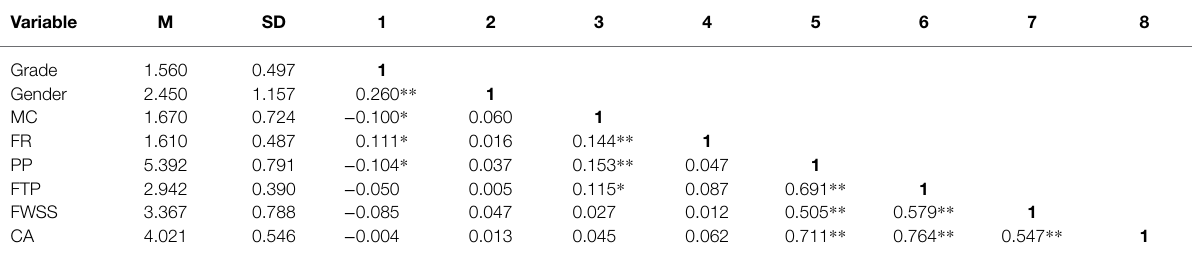
TABLE 2 | Means, standard deviations, and correlations.